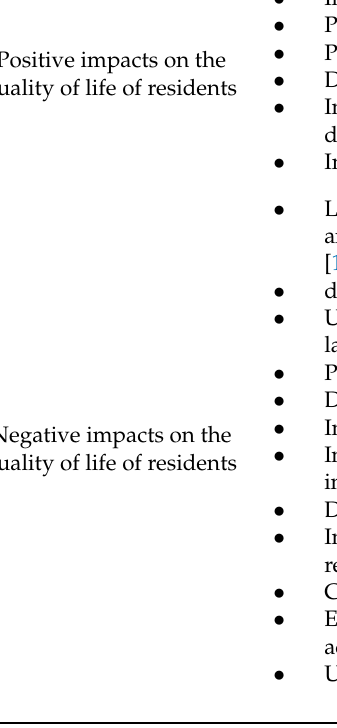
Positive impacts on the quality of life of